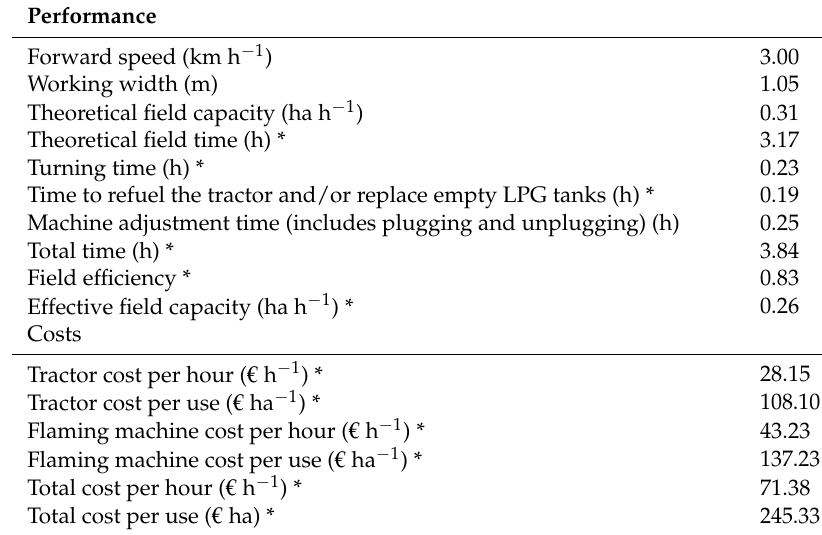
Table 7. Flaming machine performance and costs estimation. The machine was used coupled with a SAME Frutteto 100